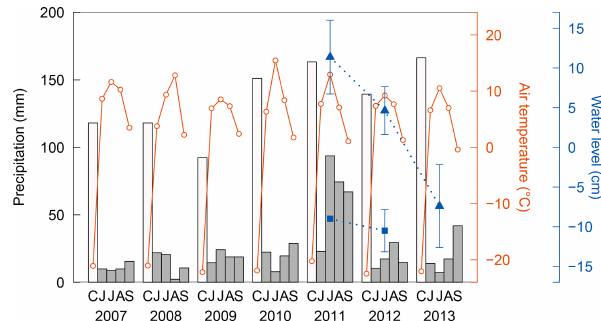
Figure 3. Interannual variations in averaged CH 4 flux in tree mounds (denoted as “Tr”) and wet areas (“Wt”) for the main sum- mer seasons from 2009 to 2013. Replication numbers (“ n ”) are shown for each averaged flux value, and standard deviations are rep- resented by error bars. Different letters show statistical interannual differences in the flux values for wet areas. See Table S2 for flux values at respective observation